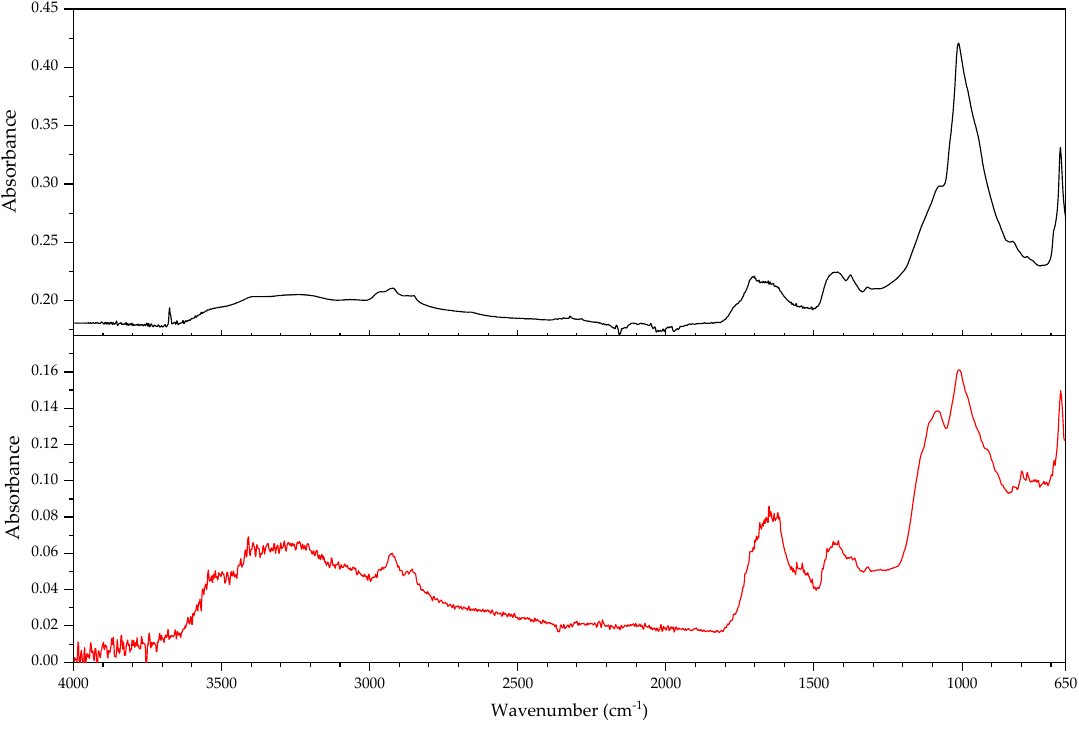
Figure 22. FTIR spectrum of the blooming of object 579 (black line) compared to the FTIR spectrum of the rubber material on which it was found (red line).